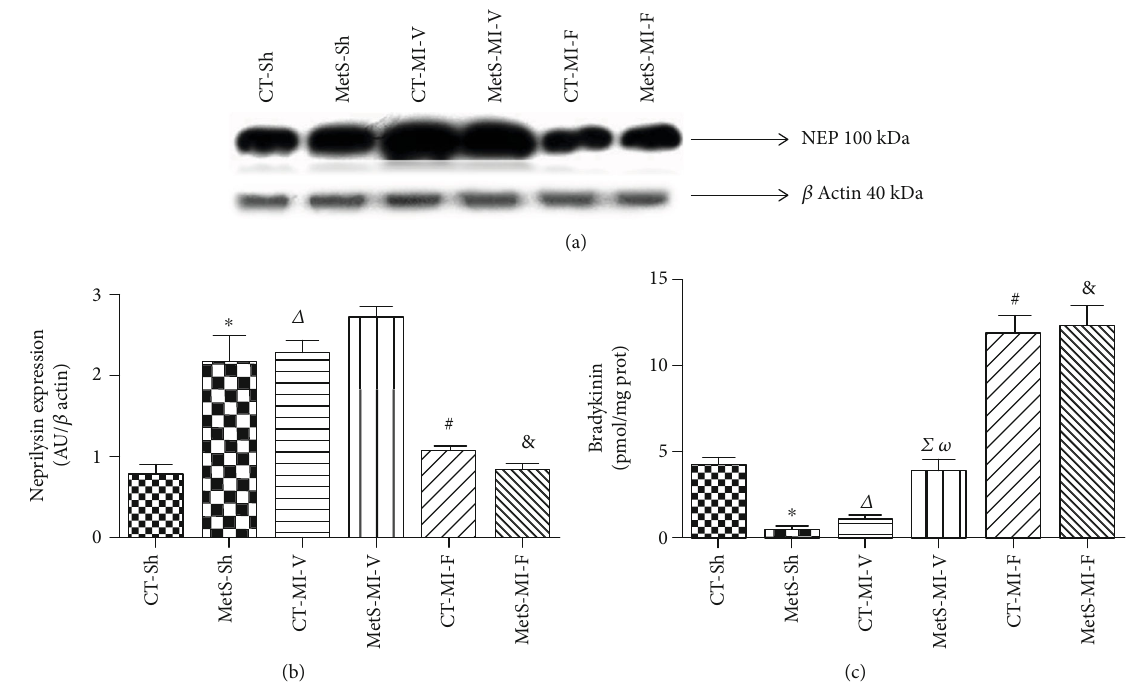
Figure 6: E ff ect of feno fi brate on the expression of neprilysin (NEP) and bradykinin concentration in control and under ischemic conditions. (a) Representative western blot analysis. (b) NEP protein expression. (c) Bradykinin concentration. The values show the mean ± SEM ( n = 5 per group). ∗ p < 0 : 05 vs. CT-Sh; Δ p < 0 : 05 vs. CT-Sh; Σ p < 0 : 05 vs. MetS-Sh; # p < 0 : 05 vs. CT-MI-V; ω p < 0 : 05 vs. CT-MI-V; & p < 0 : 05 vs. MetS-MI-V. Analysis of variance-Newman-Keuls.